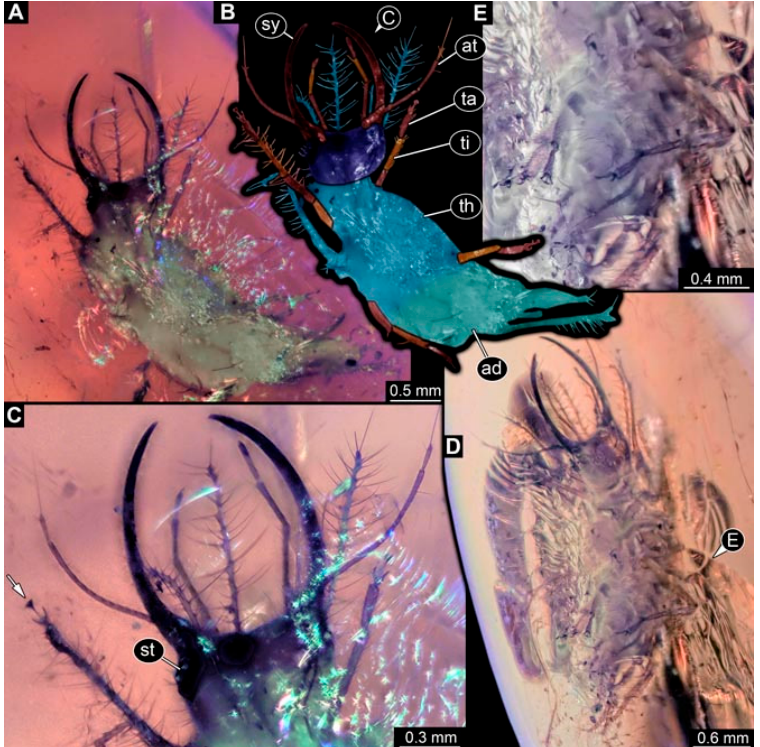
Figure 13. Specimen 4833 (PED 0251); Myanmar amber. ( A ) Dorsal view. ( B ) Dorsal view, colour- marked. ( C ) Close-up of head capsule in dorsal view and close-up of trunk appendage with empo- dium (arrow). ( D ) Ventral view. ( E ) Close-up of trunk appendages. Abbreviations: ad = abdomen; at = antenna; st = stemmata; sy = stylet; ta = tarsus; th = thorax; ti = tibia.